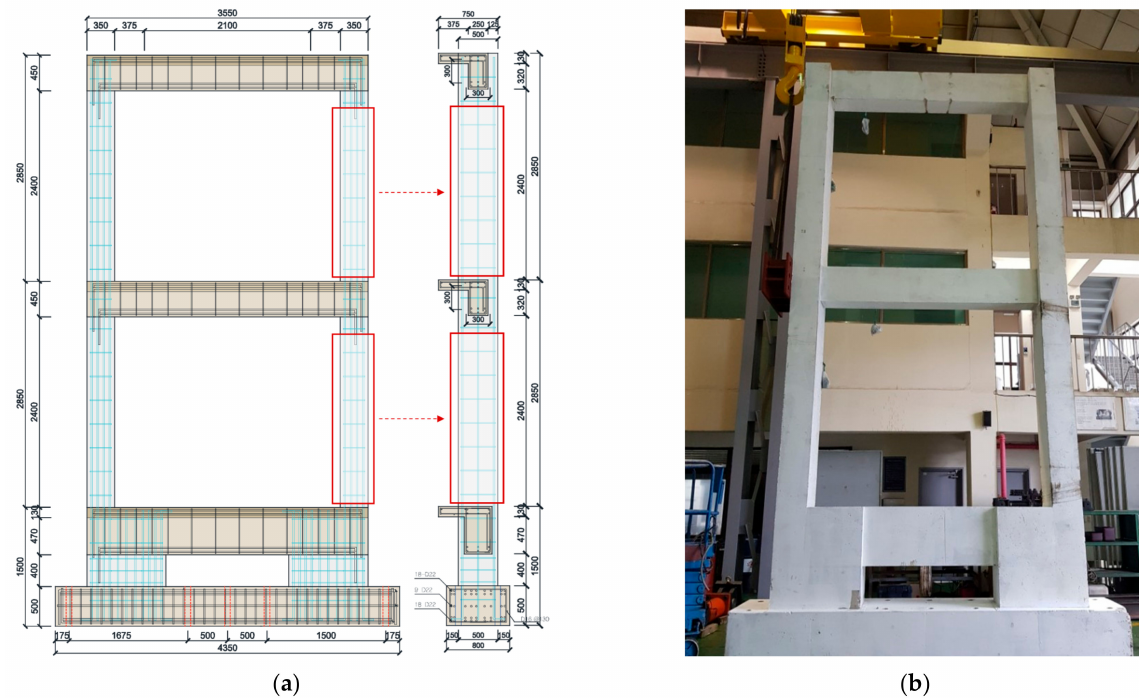
Figure 8. Bar arrangement details and image of existing frame with no reinforcement applied (PD-FR specimen, control bare frame for pseudo-dynamic testing): ( a ) bar arrangement details and ( b ) image.